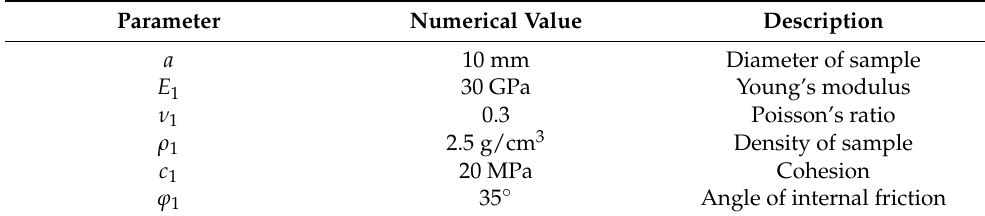
Table 1. Related parameters of the rock mechanics.